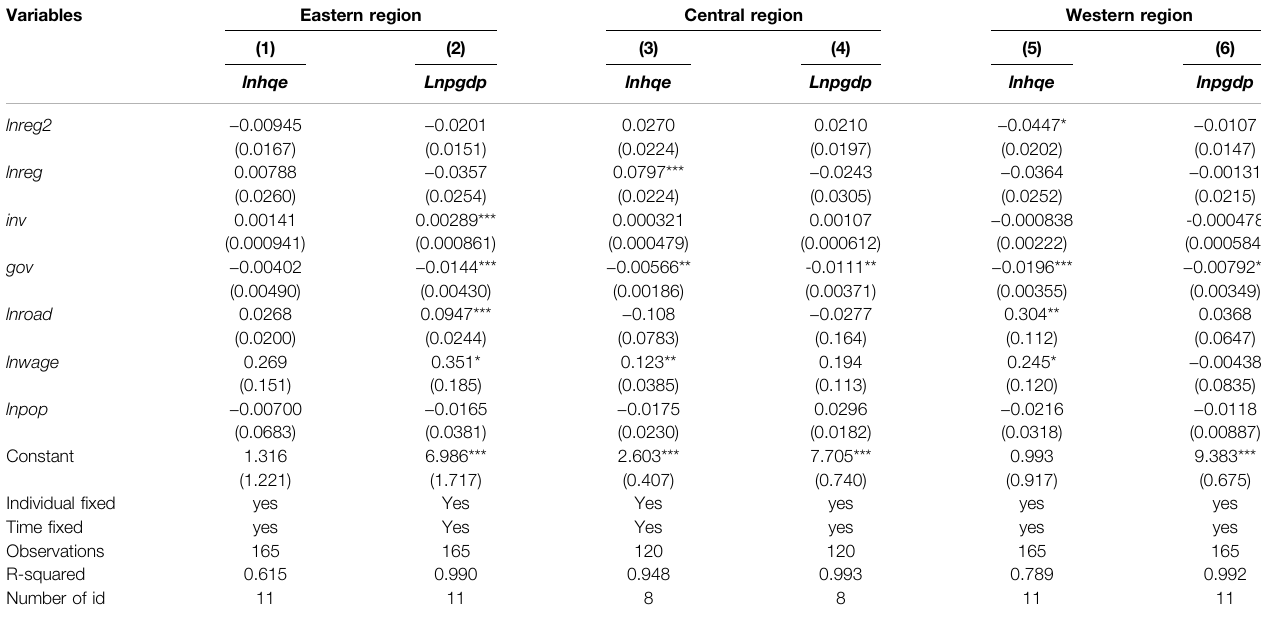
TABLE 7 | The regional heterogeneity of environmental regulation.